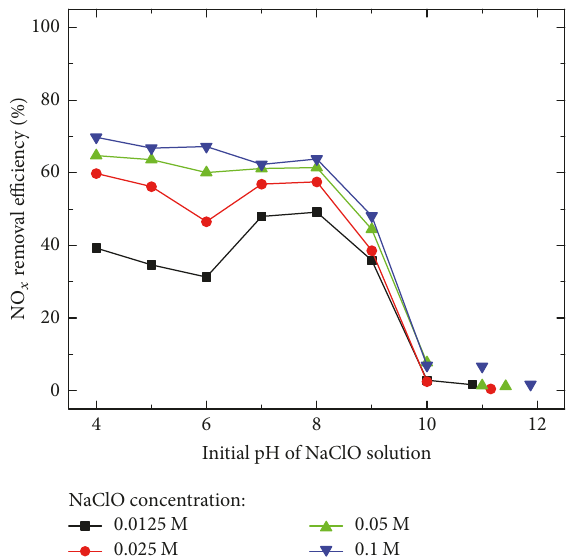
removal efficiency x concentration is 1000 ppm, NaClO x